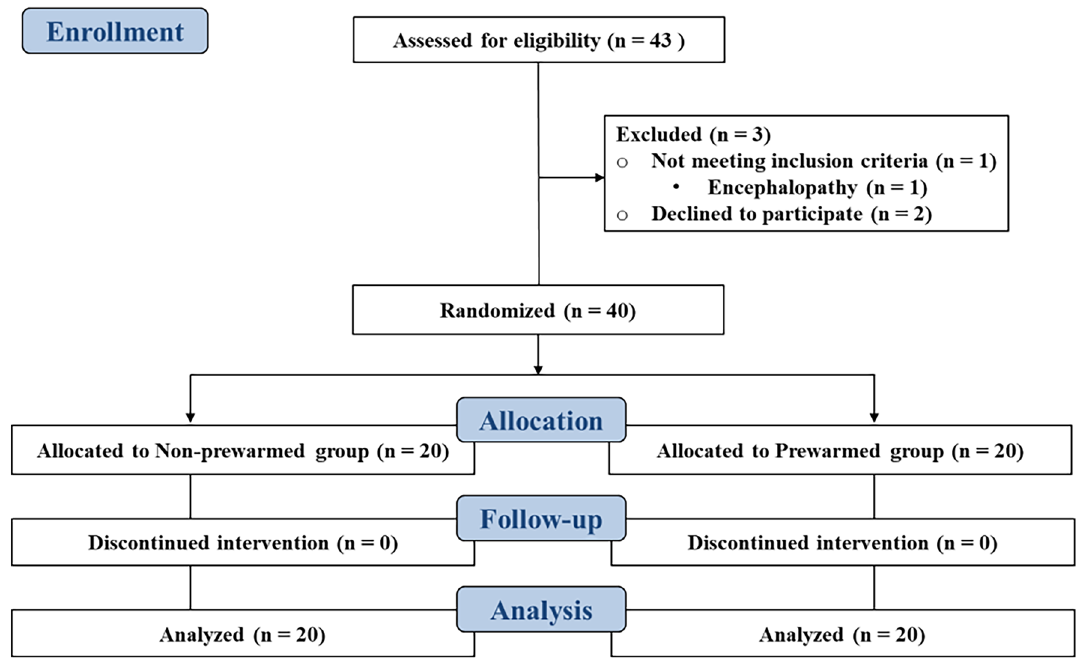
Figure 1. Consolidated standards of reporting trials (CONSORT)